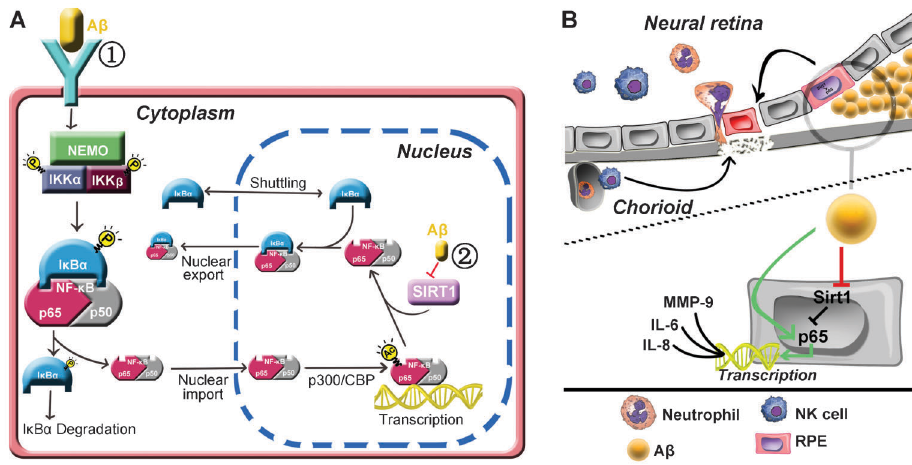
Figure 7. Schematic illustration of the effect of OA b on the NF- k B/SIRT1 pathway in cells and the role of OA b in the chronic inflammation of AMD in tissue. A , A b induces NF- k B signaling via inhibition of SIRT1. 1 : Binding of A b to an extracellular receptor, such as TLR4, leads to phosphorylation of IKK complex subunits (NEMO, IKK a and IKK b ), which subsequently phosphorylate I k B a and lead to its proteosomal degradation. This then releases NF- k B into the nucleus. 2 : Newly liberated NF- k B can be acetylated for full- transcriptional activation. However, the acetylated NF- k B can also be deacetylated by SIRT1. This action of SIRT1 promotes I k B a binding and nuclear export of the deacetylated NF- k B complex, which terminates the NF- k B response and replenishes the cytoplasmic pool of latent NF- k B/I k B a complexes. B , A b -induced expression of IL-8, IL-6 and MMP-9 contributes to chronic inflammation in age- related macular degeneration. Figure adapted from Refs.